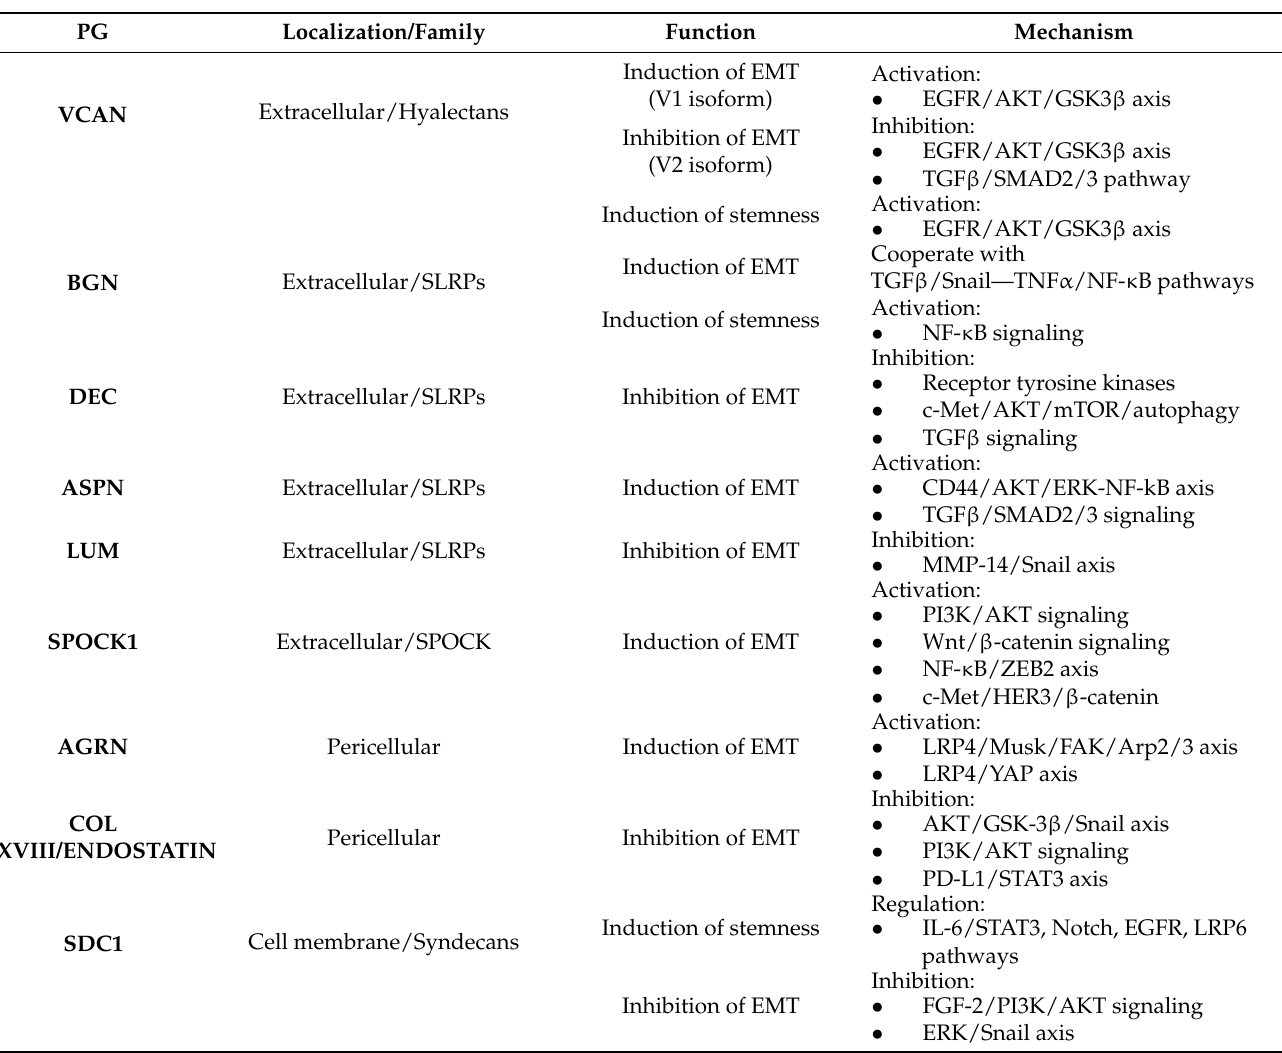
Table 1. Main roles of PGs in cancer cell EMT and